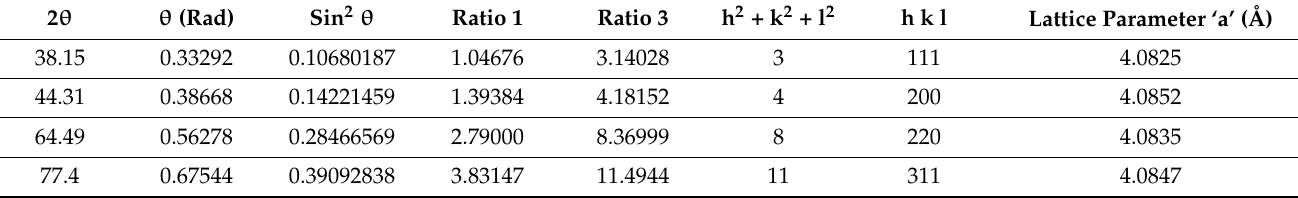
Table 1. The hkl plane of Ag-NPs calculation using 2 θ values from XRD